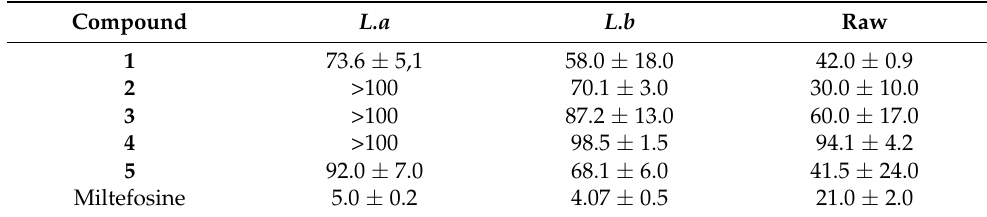
Table 3. Leishmanicidal activity against leishmanial promastigotes (L.a: Leishmania amazonensis ; L.b.: L. braziliensis ) and cytotoxicity in murine macrophage cells (Raw 264.7 cells), of compounds 1 – 5 and the positive control miltefosine. The data are given as IC 50 values in µ g/mL (see Experimental section for